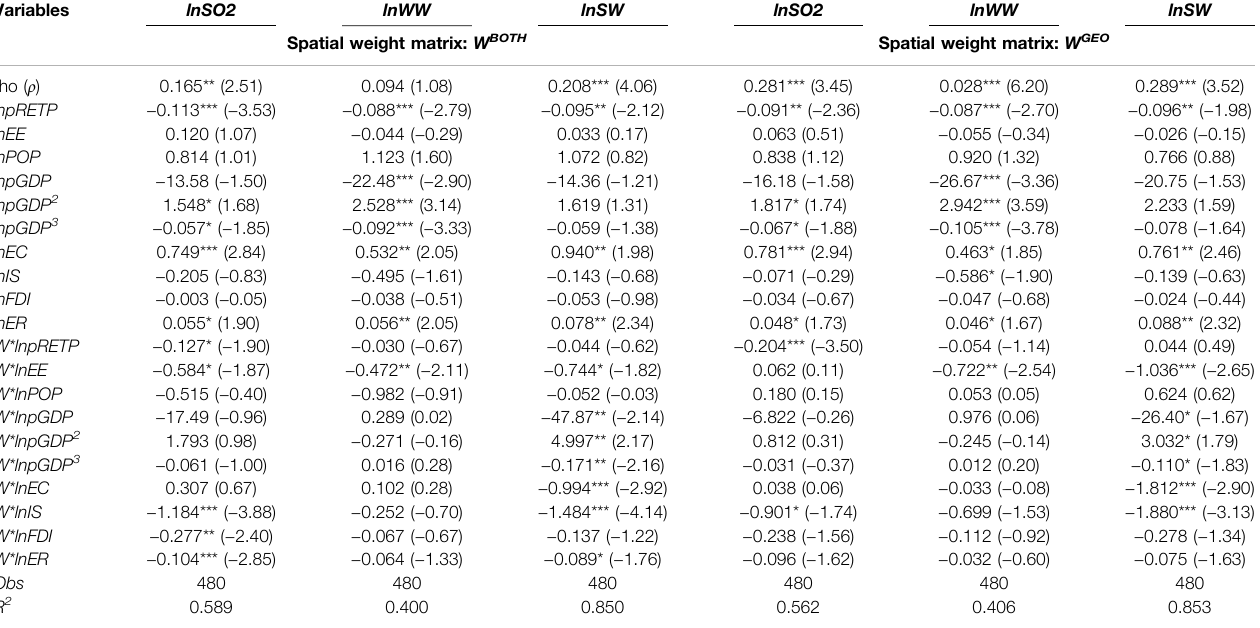
TABLE 8 | Robustness test with alternative variable in spatial econometric model (SDM).